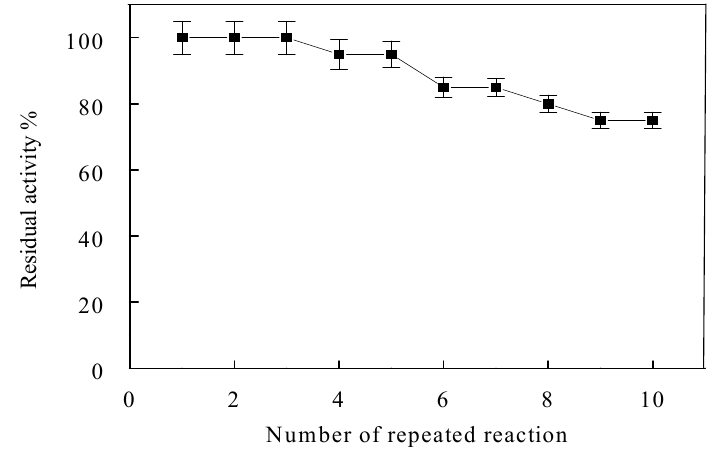
Figure 4. Reuse of wool- α -amylase. Each point represents the mean of three experiments ±